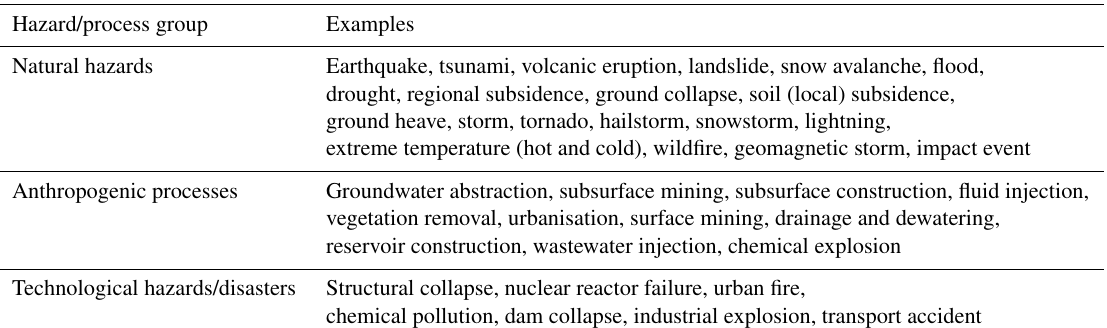
Table 1. Examples of hazard/process types, grouped into three categories: natural hazards (classification of 21 hazards from Gill and Mala- mud, 2014), anthropogenic processes and technological